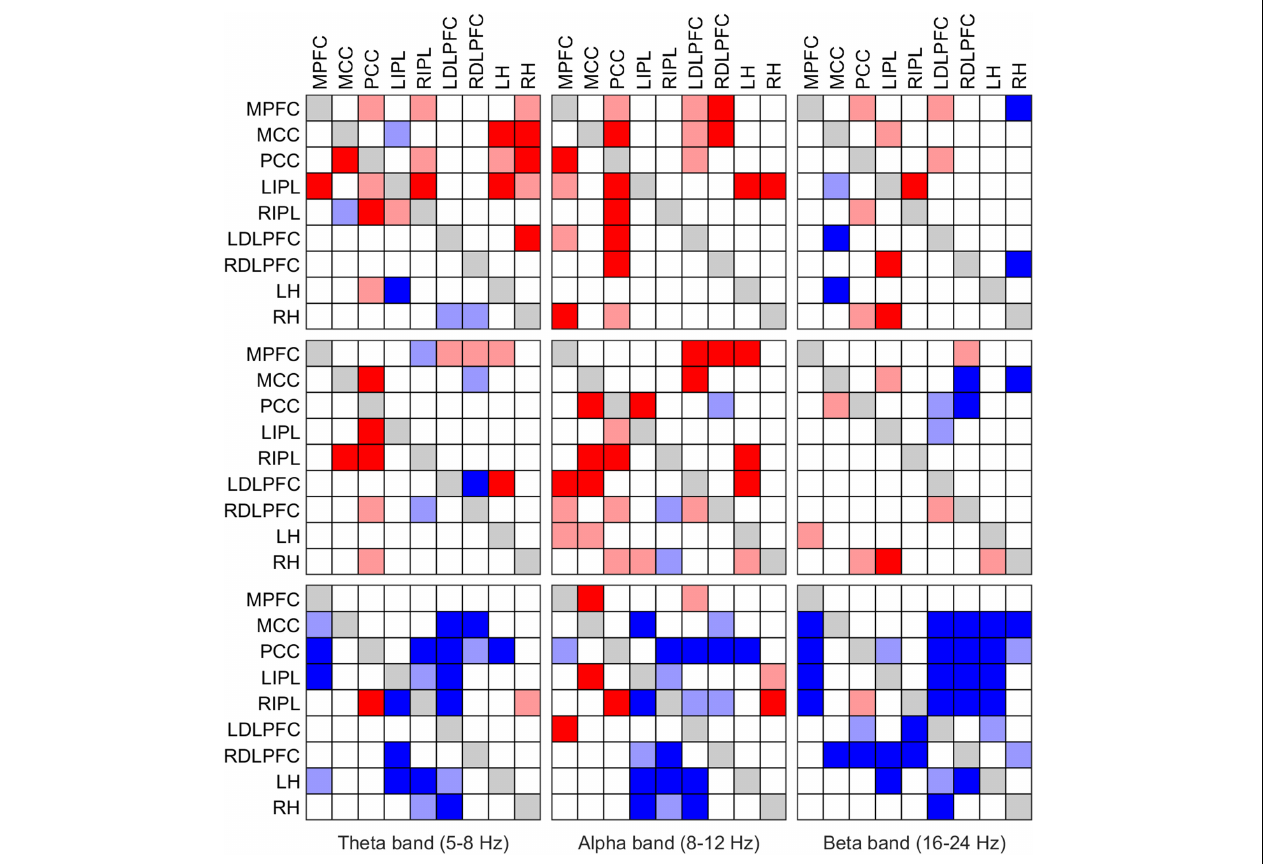
FIGURE 5 | Significant change of iCOH (connectivity) in the theta (left column), alpha (middle column) and beta band (right column) at the SOn transition in baseline (top) and recovery (middle) and after SOn between baseline and recovery (bottom). For details see Figure 4